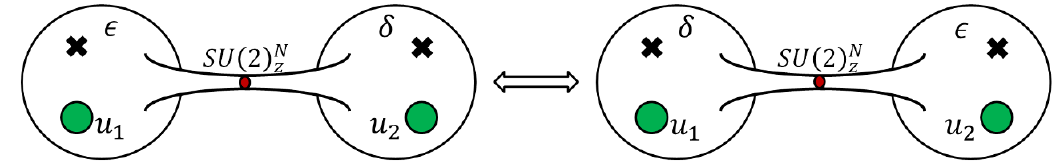
Figure 10 . Di(cid:11)erent duality frames for a four punctured sphere. The fact that the left and right frames are the same implies for example that the index has to be invariant under exchange of the two SU(2)